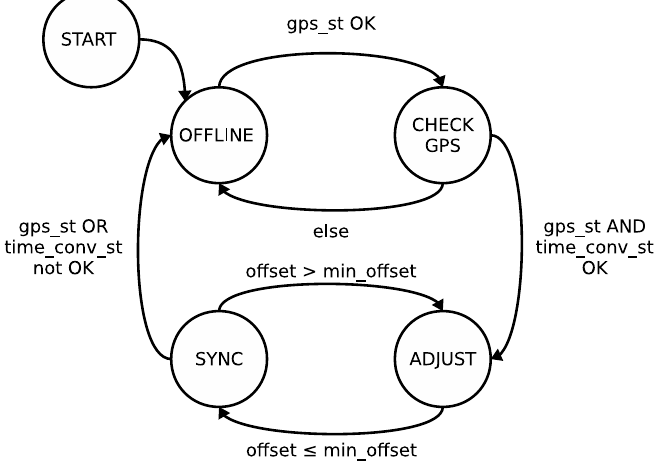
Figure 12. States of the synchronization